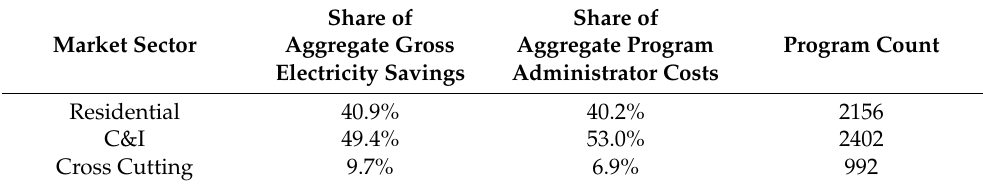
Table 3. Share of aggregate gross electricity savings and program administrator spending by market